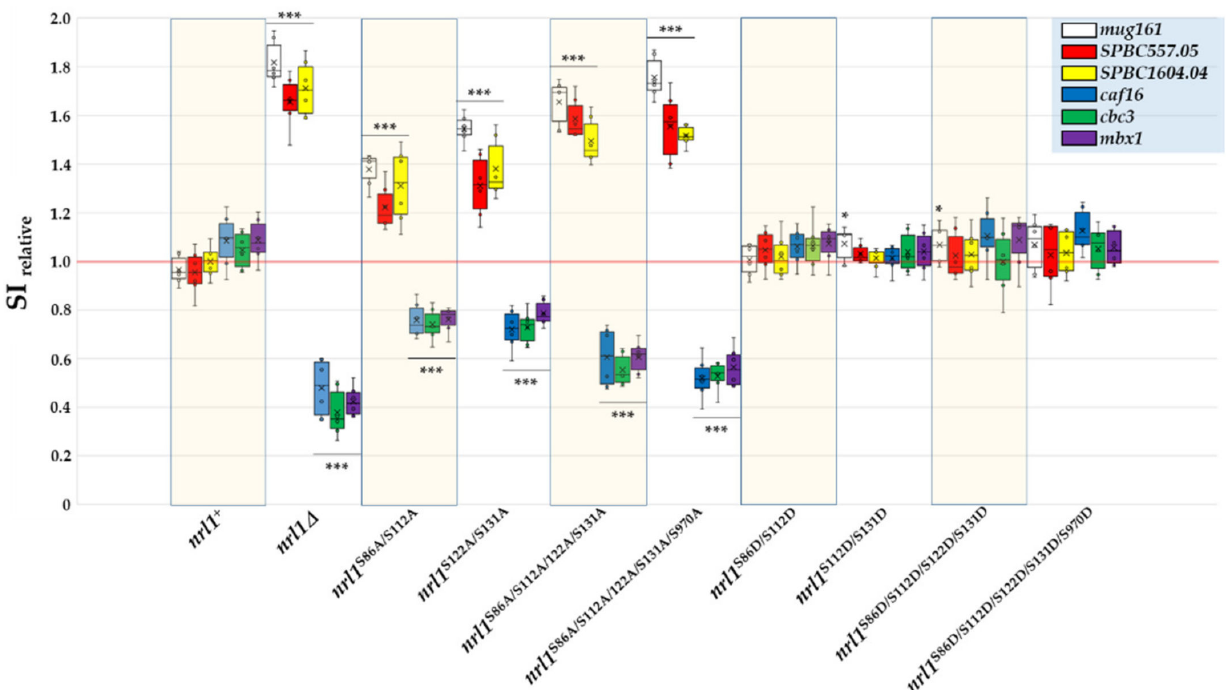
Figure 8. Analysis of splicing efficiency in nrl1 ∆ and phosphorylation-site mutants nrl1 S/A and nrl1 S/D . The relative splice-index (SI relative) is shown for the 3rd intron of mug161 and 1 st introns of SPBC557.05 , SPBC1604.04 , caf16 , cbc3 , and mbx1 . The data represent mean values ± S.D. of splicing index (SI) relative to wild-type from three independent biological replicates. Statistical significance in splicing of studied genes in nrl1 mutants compared to wild-type nrl1 + was determined using one-way analysis of variance (ANOVA) ( p -values: *– p ≤ 0.05 and ***– p ≤